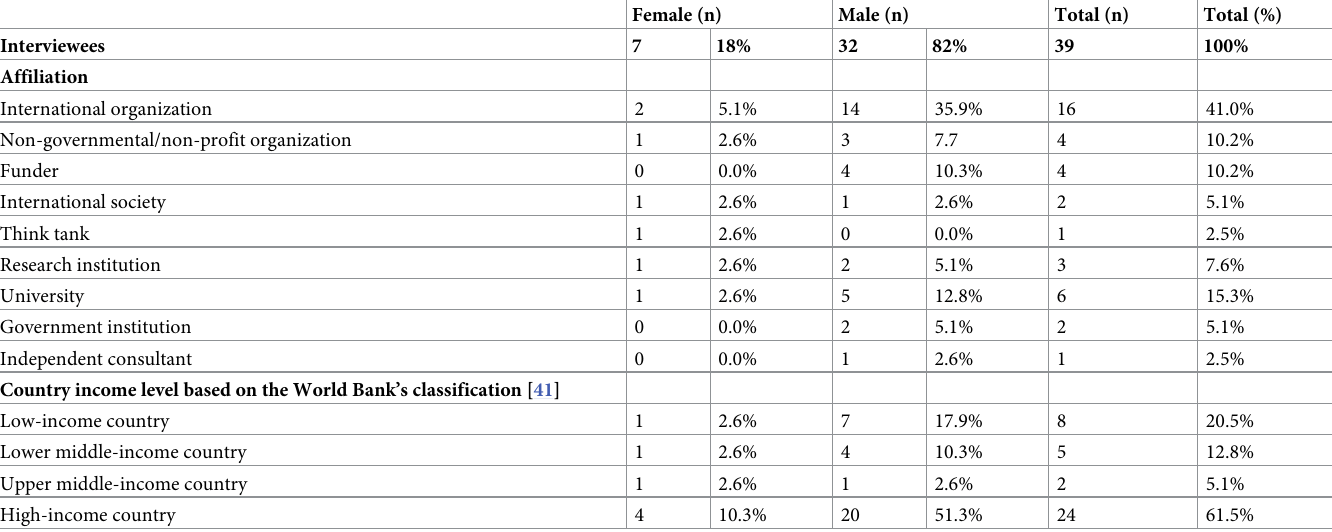
Table 1. Institutional affiliation, sex and geographical location of